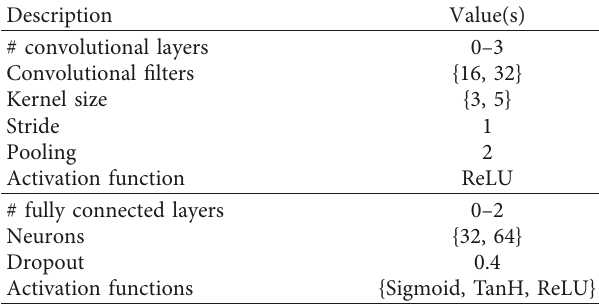
Table 2: Search space restrictions for grid